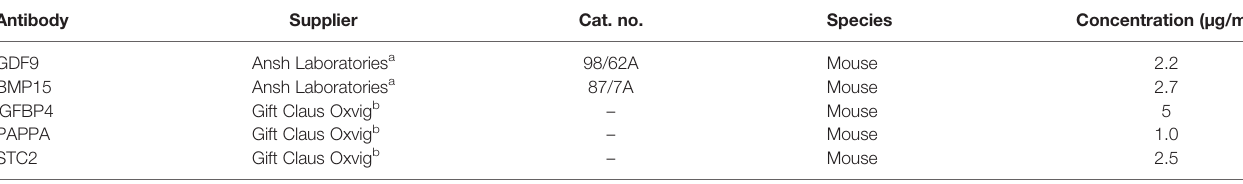
TABLE 2 | Antibodies and conditions used for IHC